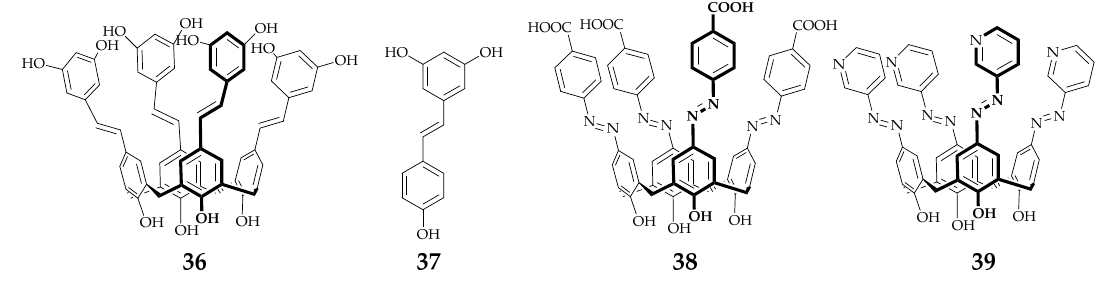
Figure 6. Structures of calix[4]arene derivatives 36 – 39 .